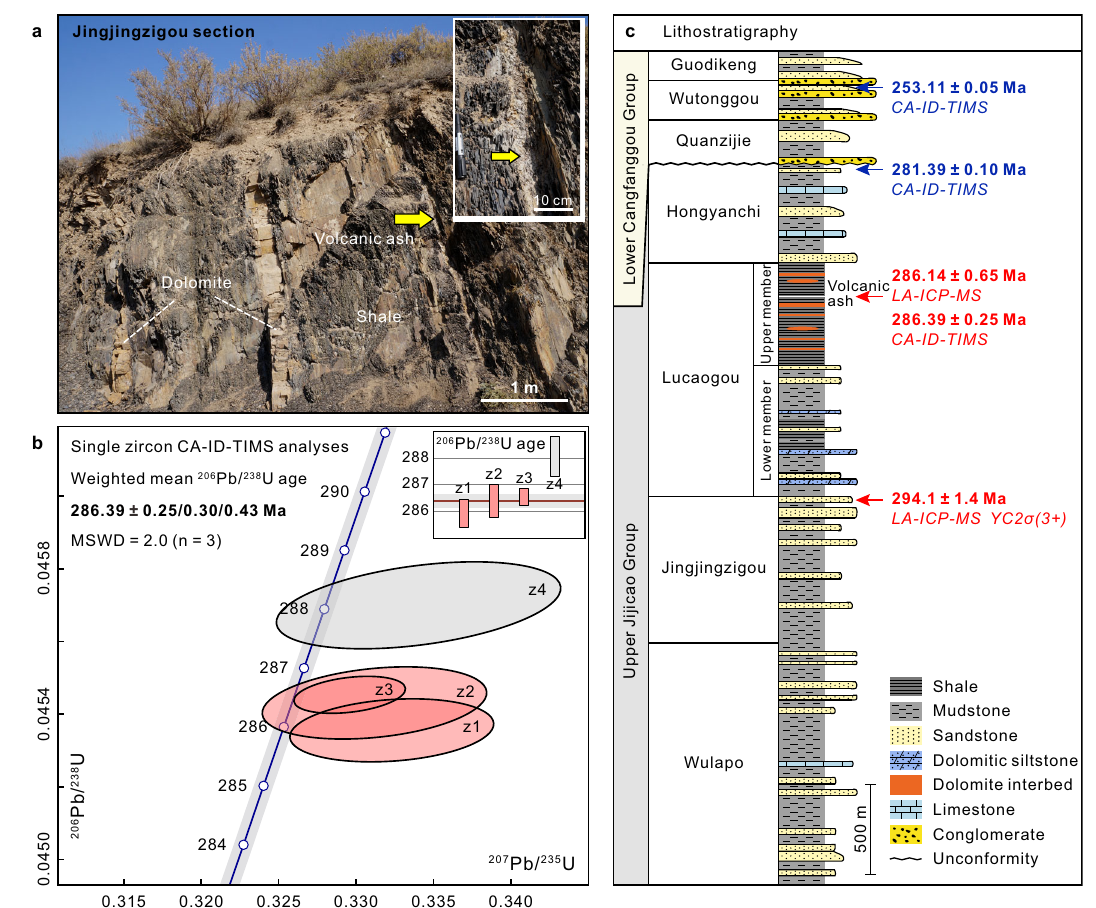
Fig. 2 | Permian stratigraphy and geochronology of the southern Junggar Basin.a Outcropphotographoforganic-richshaleinterbeddedwithdolomitebeds andnodulesfromtheuppermemberoftheLucaogouFormation.Thearrowpoints to the location of the volcanic ash bed (sample VA-1) sampled for zircon geo- chronology (inset shows a close-up view of the ash bed). b Concordia plot and 206 Pb/ 238 U ages of zircons analyzed using the U-Pb CA-ID-TIMS method; excluded